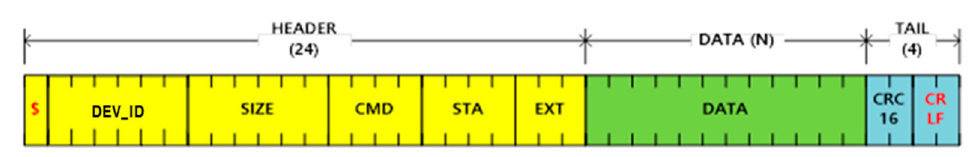
Figure 7. Communication protocol of DiverPAD.